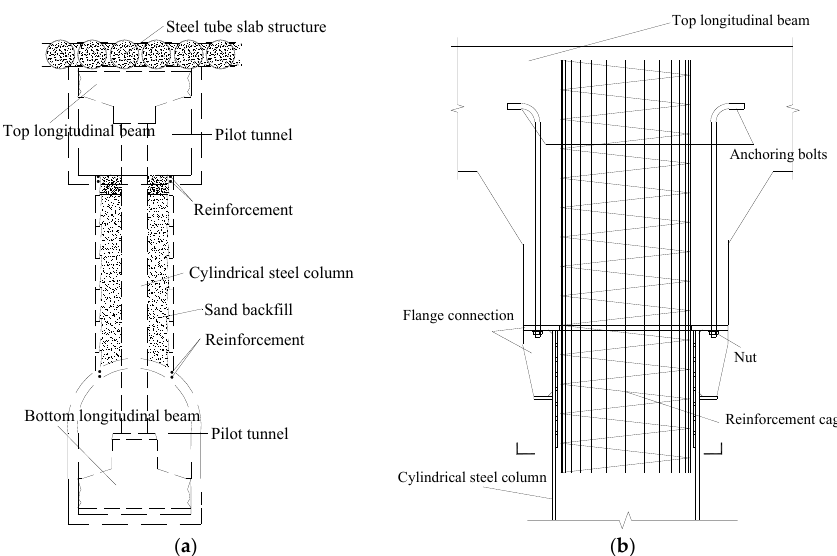
Figure 8. Connection between cylindrical steel columns and longitudinal beams: ( a ) Beam-column supporting system; ( b ) The connection nodes.